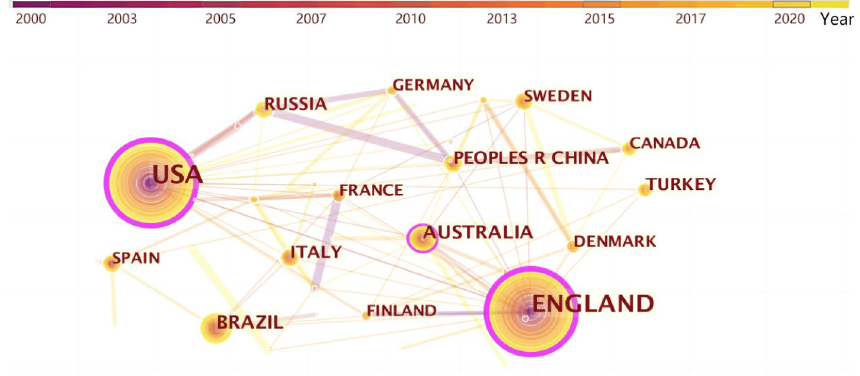
Fig. 3 Co‑relationships between nations in “fashion design”